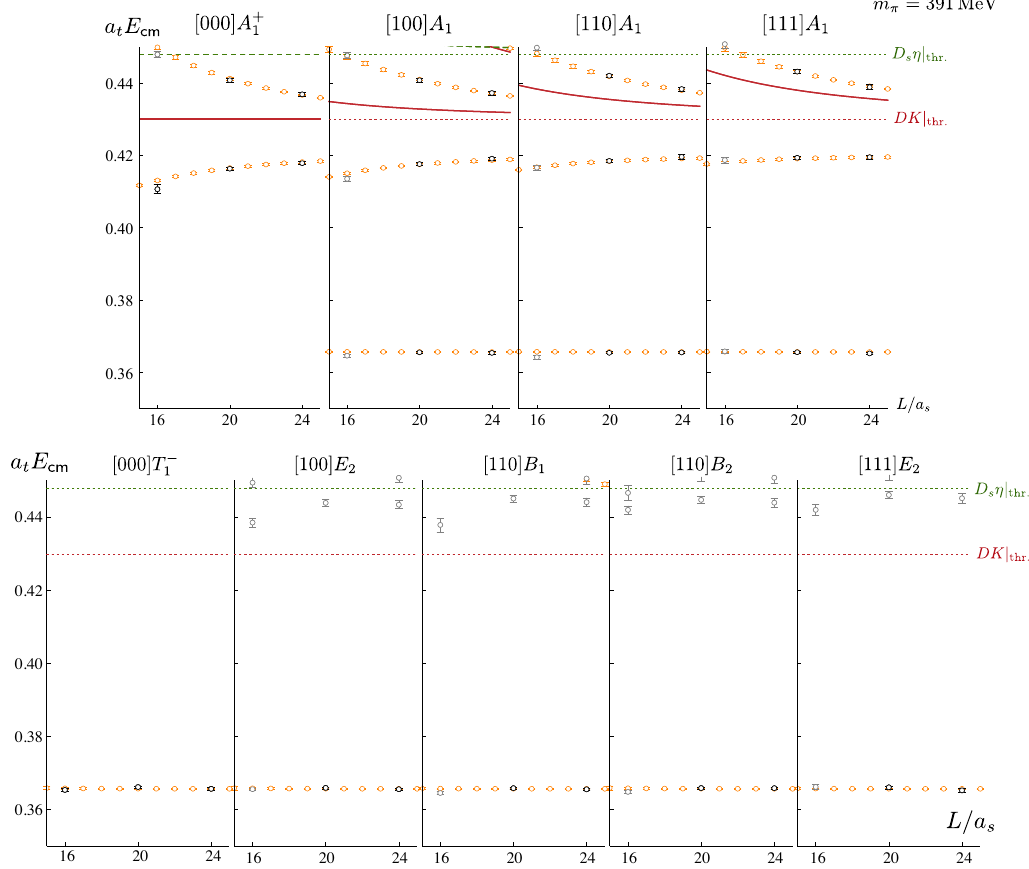
Figure 8 . DK I = 0 finite-volume spectra on the m π = 391 MeV ensembles, as in the top two rows of figure 4, with the addition of orange points which show the energy levels from the parametrisation in eq.